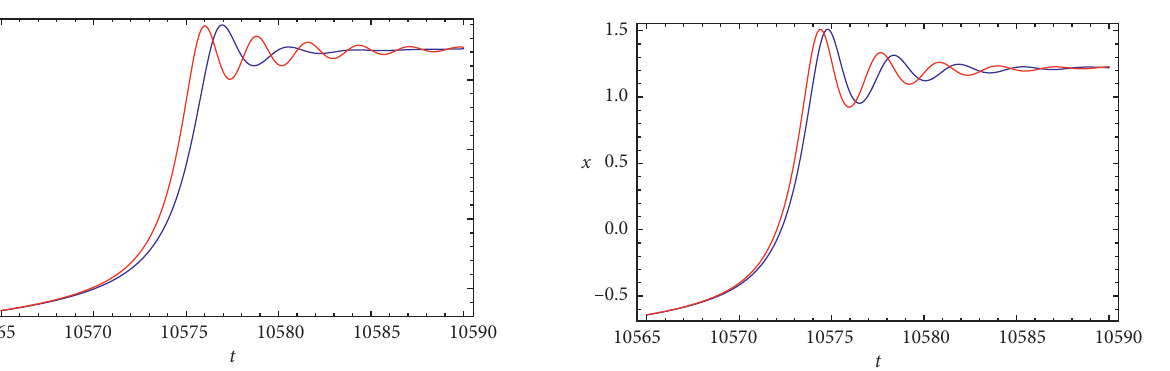
Figure 14: Time history of system (36). The red line represents the curve before time-delay approximation, and the blue line repre- sents the curve after time-delay approximation when the param- � 0 . 01 ,f � 1, and τ � 0 . eters are a � b � α � 1 , ω 2 1